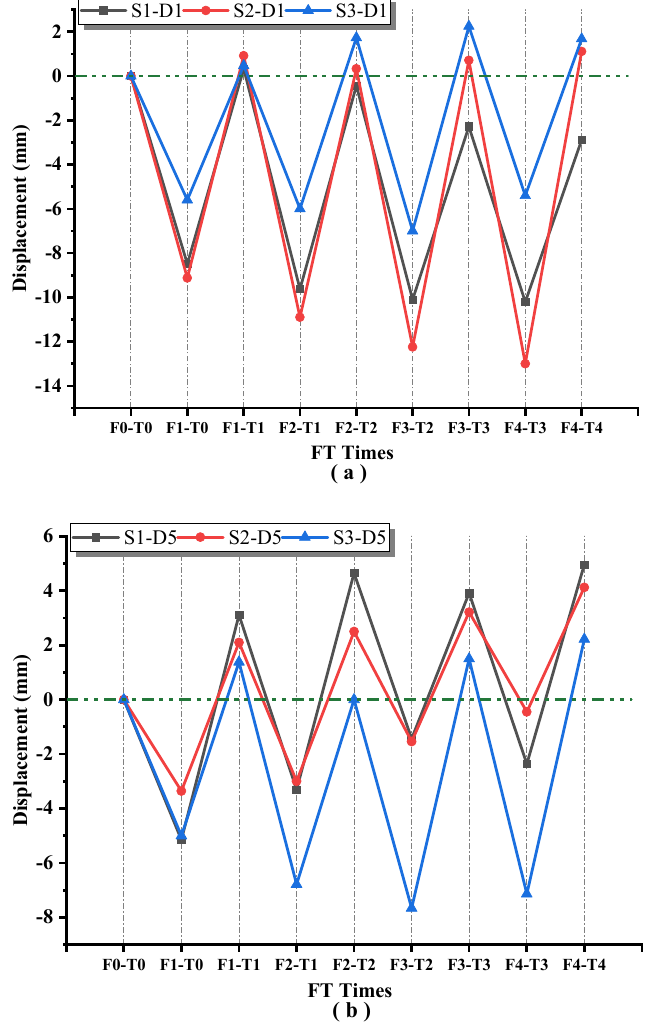
Figure 13. Slope displacement variation after freezing and thawing. ( a ) Slope bottom displacement; ( b ) slope top displacement.